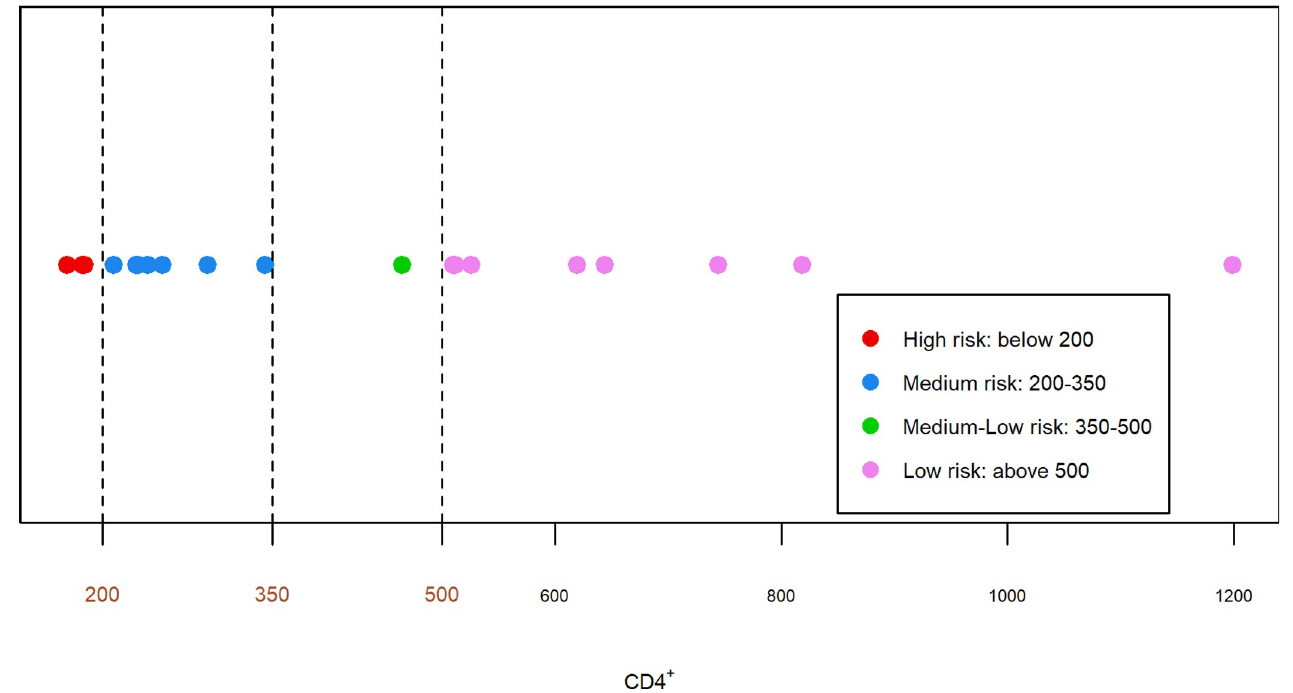
Fig 1. Severity of HIV disease based upon CD4 + cell